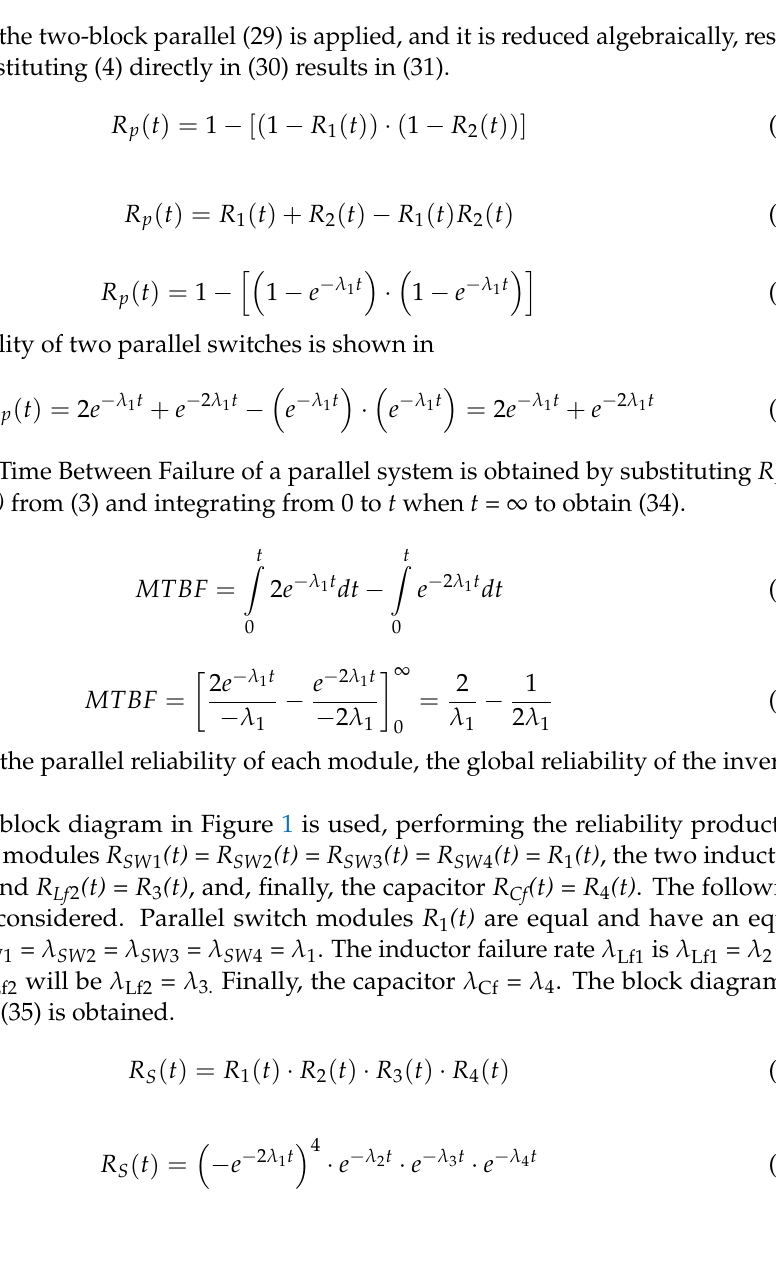
Figure 5. Analysis of full bridge inverter with parallel MOSFET structure.